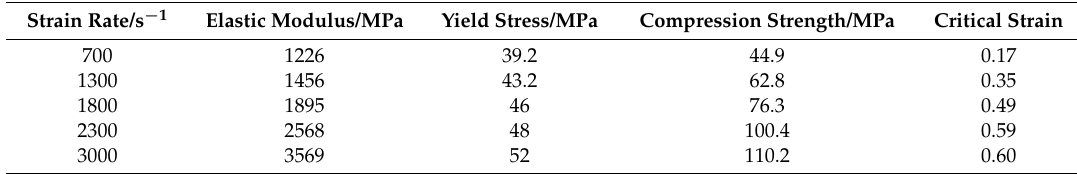
Figure 8. True stress-strain curves of PTFE/Al/MoO 3 specimens under dynamic impact. Table 2. Dynamic performance parameters of PTFE/Al/MoO 3 . (specimens at different strain rates). Strain Rate/s − 1